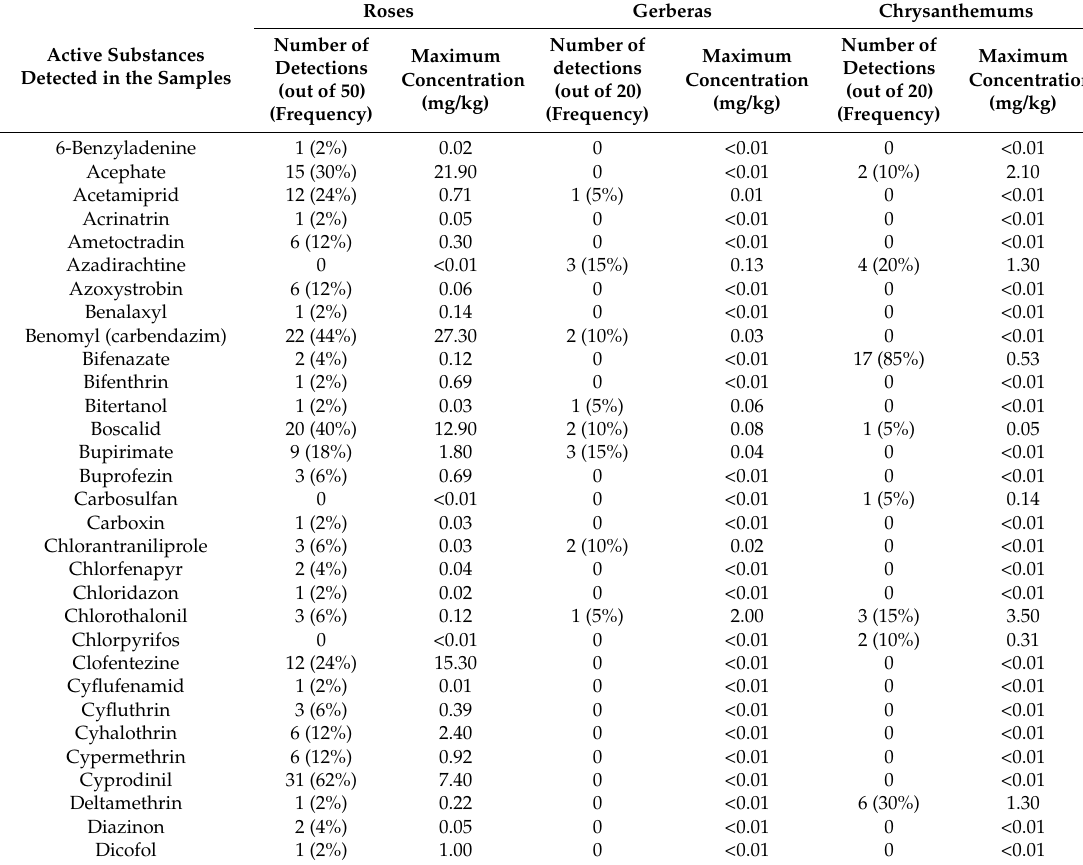
Table 6. Alphabetic classification of all a.s. present in the 90 samples of roses, gerberas, and chrysanthemums, number of detections (concentrations > LOQ), frequency (samples in % containing the a.s.), and maximum concentration